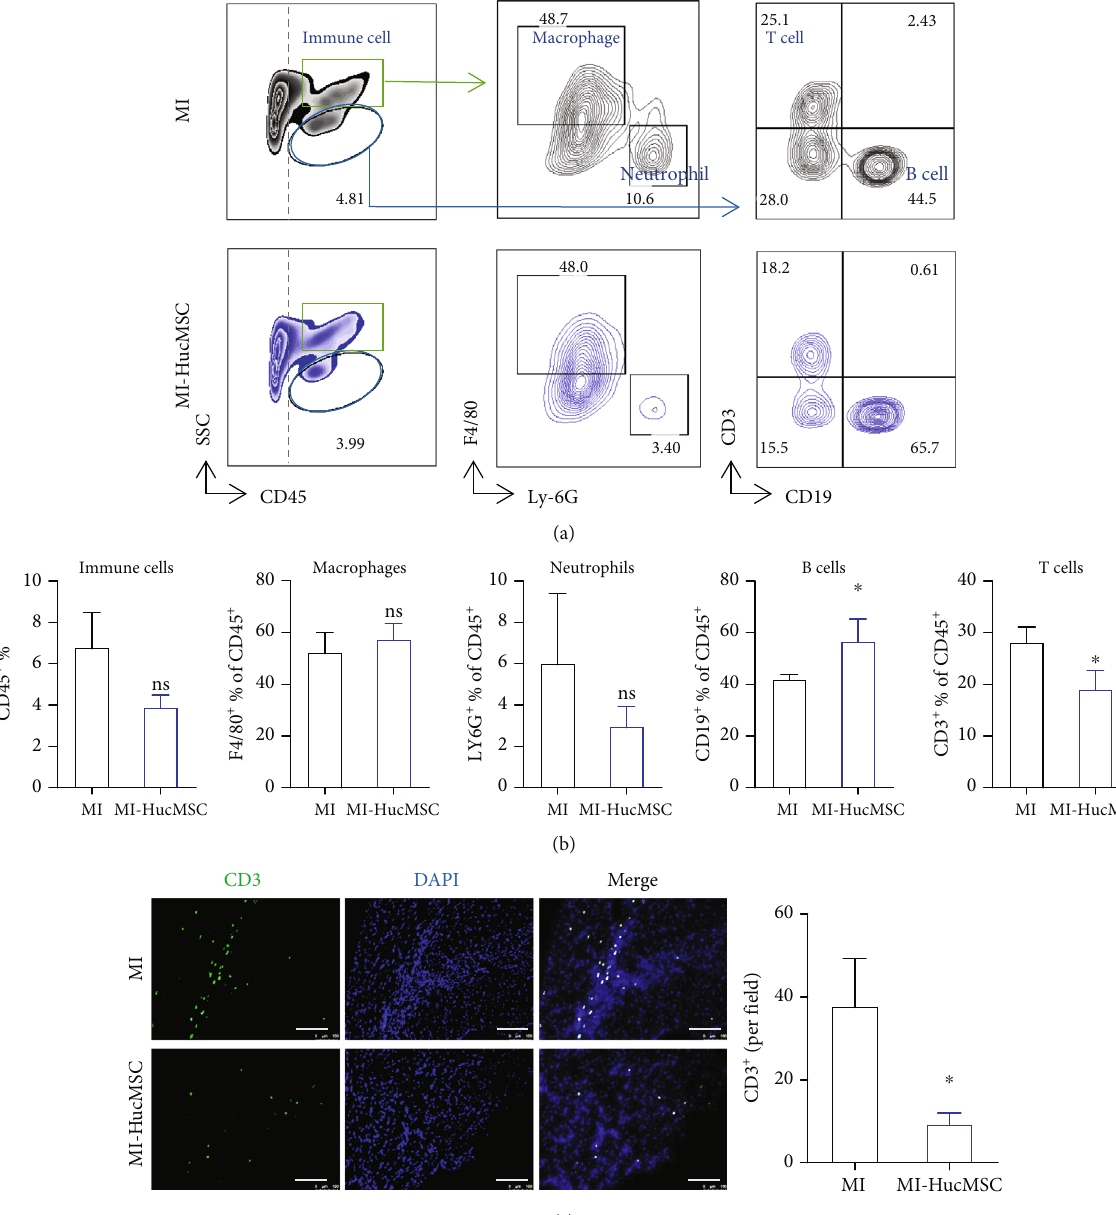
Figure 4: Cardiac immunomodulatory e ff ects of iv-administered HucMSC at 7-day post-MI. (a) Gating strategy and representative images of fl ow cytometry in the heart at 7-day post-MI. (b) Flow cytometry analysis of immune cells (CD45 + %), macrophages (F4/80 + % of CD45 + ), neutrophils (Ly-6G + % of CD45 + ), T cells (CD3 + % of CD45 + ), and B cells (CD19 + % of CD45 + ) in the heart. (c) Representative images and quantitative analysis of CD3 + T cells in the peri-infarct area. Scale bar = 100 μ m. n = 3~ 4 mice for each group. ns, non-signi fi cant vs. MI group; ∗ p < 0 : 05 vs. MI